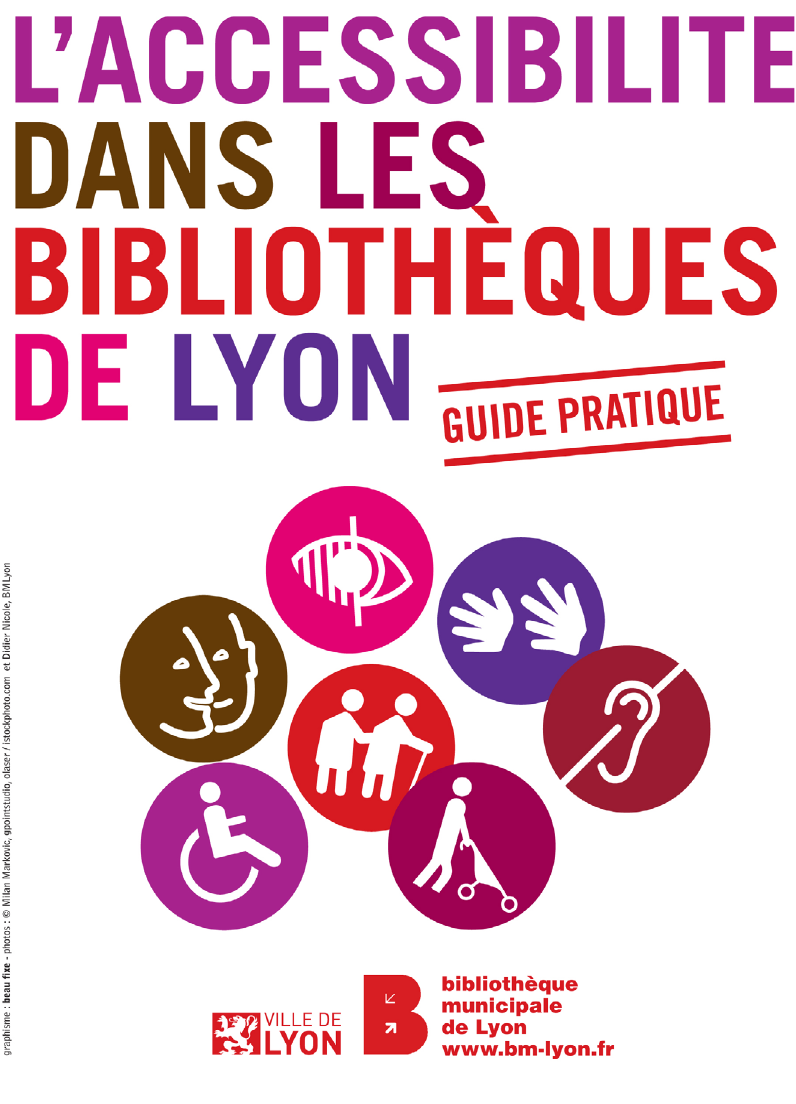
Guide for the accessibility to Lyon’s